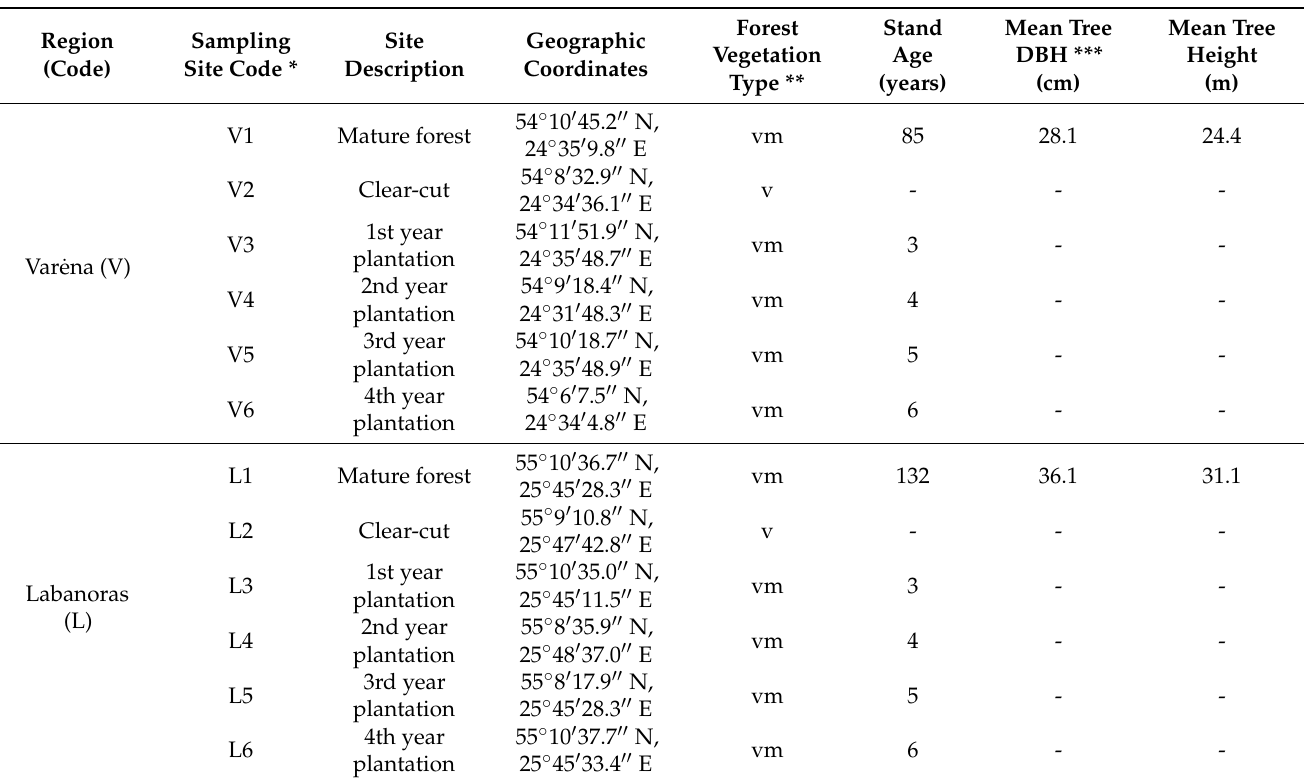
sites in Labanoras region, also shown in Figure 1. ** v: vacciniosa , m: myrtilliosa ; *** DBH: tree diam- eter at breast height (measured at 1.3 meters above the ground).